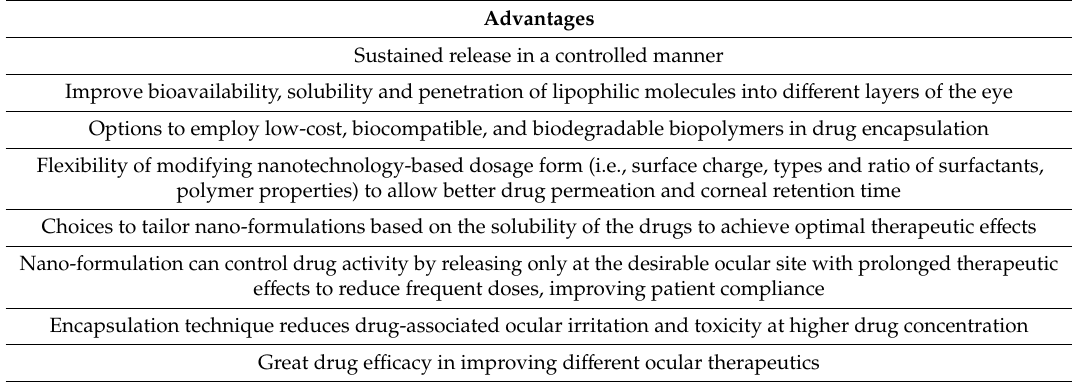
Table 2. Advantages and disadvantages of nanotechnology-based ocular drug delivery systems.